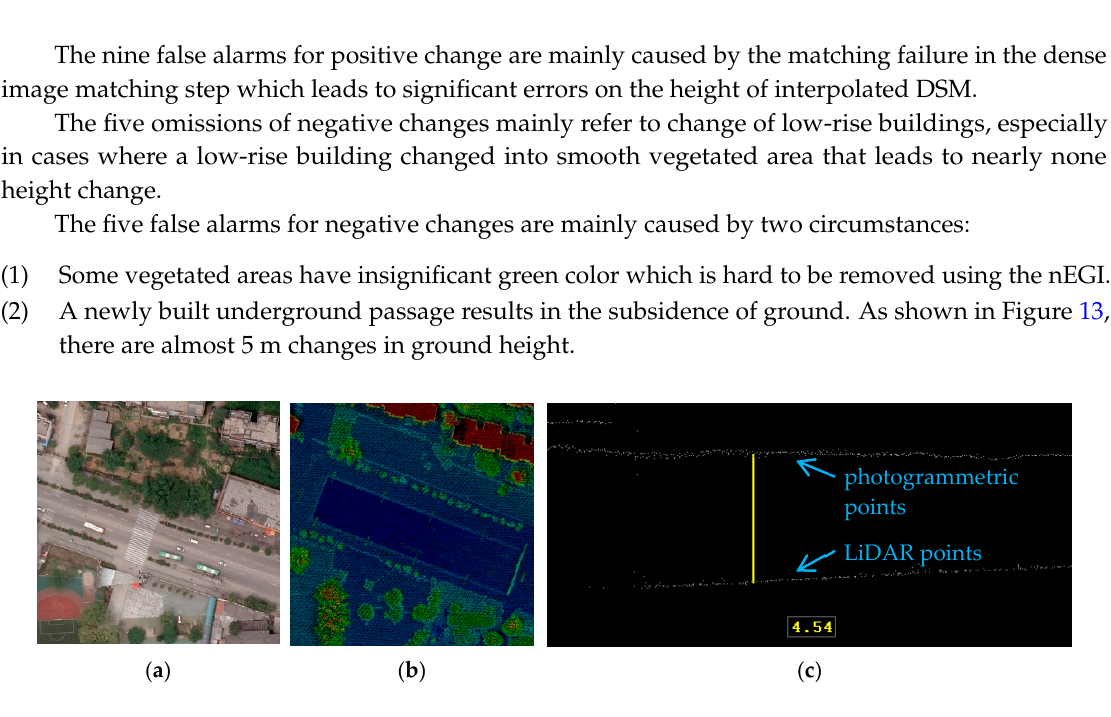
Figure 13. A newly built underground passage results in the subsidence of ground: ( a ) aerial images of this area; ( b ) LiDAR data of this area; and ( c ) the subsidence of ground.